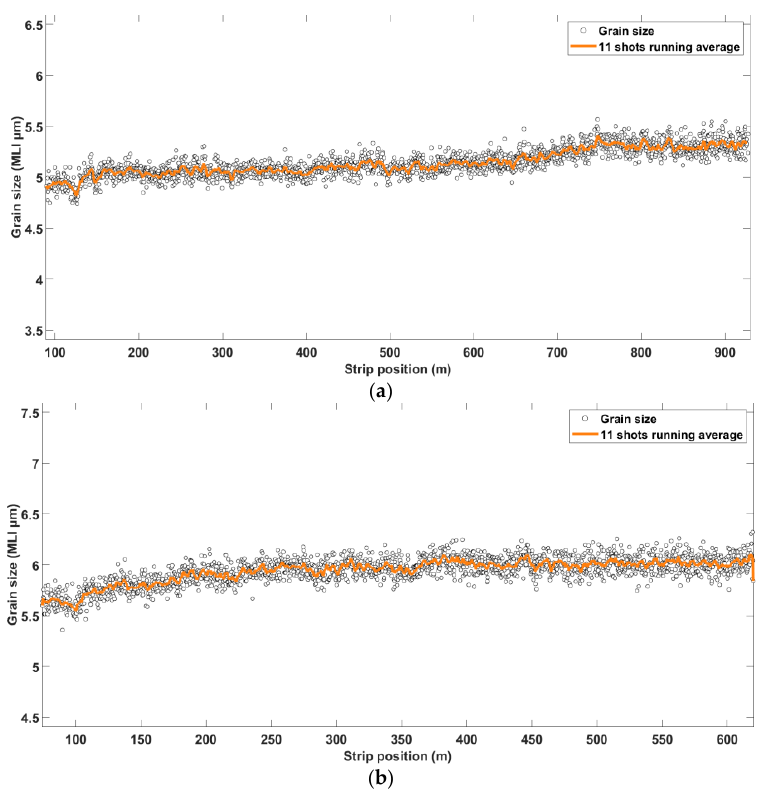
Figure 8. Calculated grain size along the length of a 1000 m ( a ) and 650 m ( b ) long strip as measured by the online LUS grain size gauge. The head and tail end were not measured due to extra safety margins employed during the first few LUS measurements performed with the new grain size gauge.